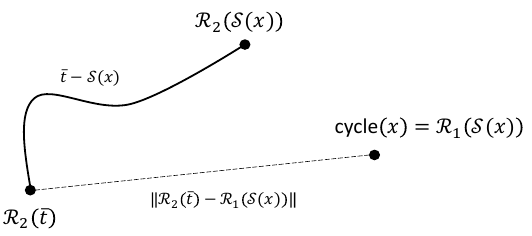
Figure 2. An abstract depiction of the trajectories of R 1 , R 2 , assuming that R 1 is the finder of the exit, located at cycle ( x ) at time S ( x ) . Time ¯ t is the time, after they start searching for the exit on the perimeter that the two robots meet at R 1 ( ¯ t ) = R 2 ( ¯ t )